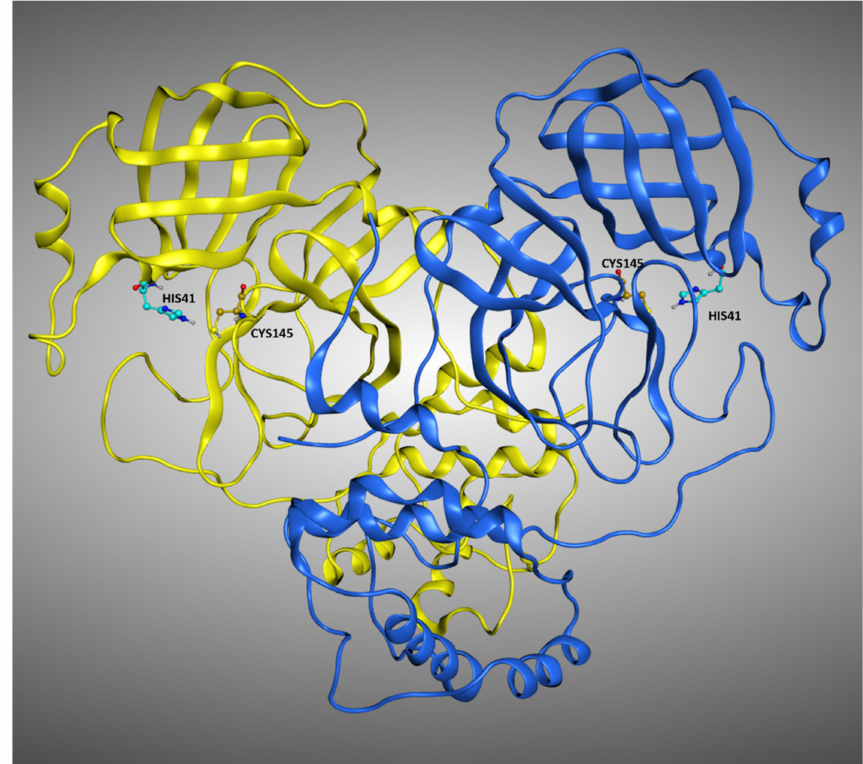
Figure 1. Representation of the crystal structure of M pro (PDB:7L10). The two monomers composing the protein are colored differently, while the residues of the catalytic dyad, Cys145, and His41 are labeled in each of the